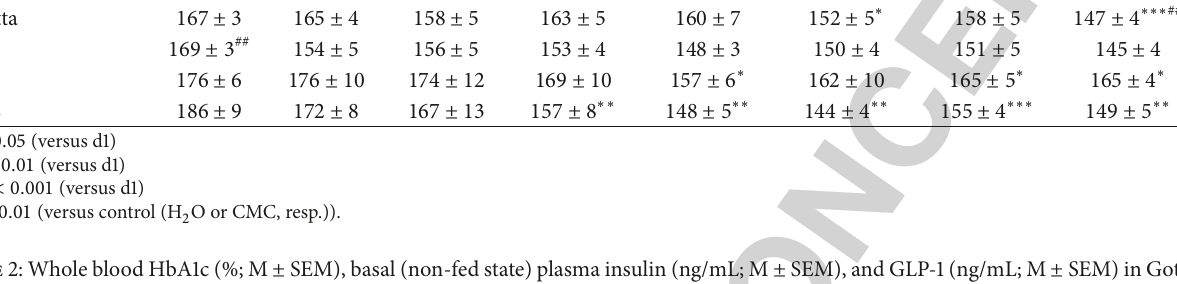
Table 2: Whole blood HbA1c (%; M ± SEM), basal (non-fed state) plasma insulin (ng/mL; M ± SEM), and GLP-1 (ng/mL; M ± SEM) in Goto Kakizaki/Par male rats ( 𝑛 = 12 in each group).